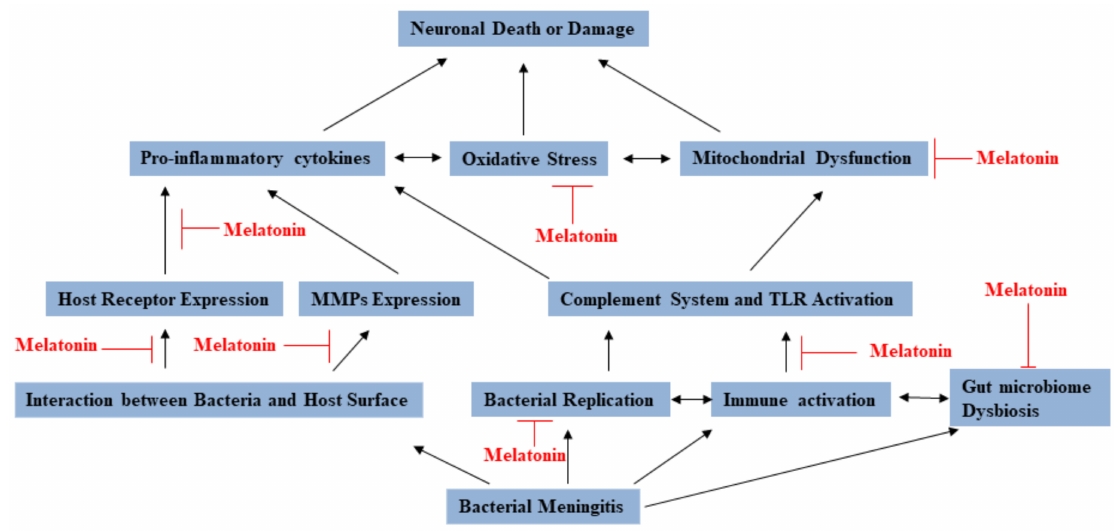
Figure 2. The multiple functions of melatonin that provide prevention and protection against bacterial